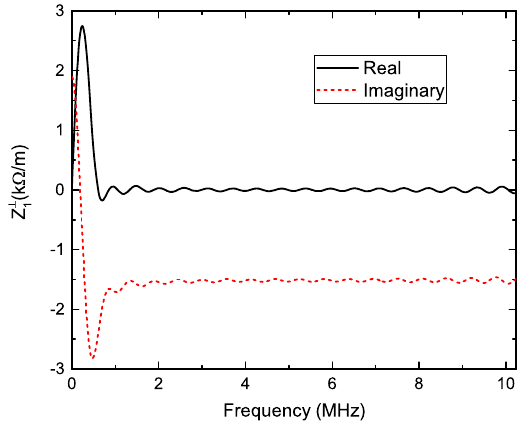
FIG. 4. The transverse impedance in a simulation (the beam path shift is 20